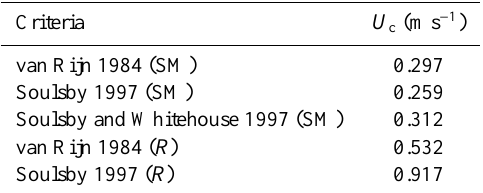
Table 4. Theoretical critical values for sediment motion (SM) and resuspension ( R